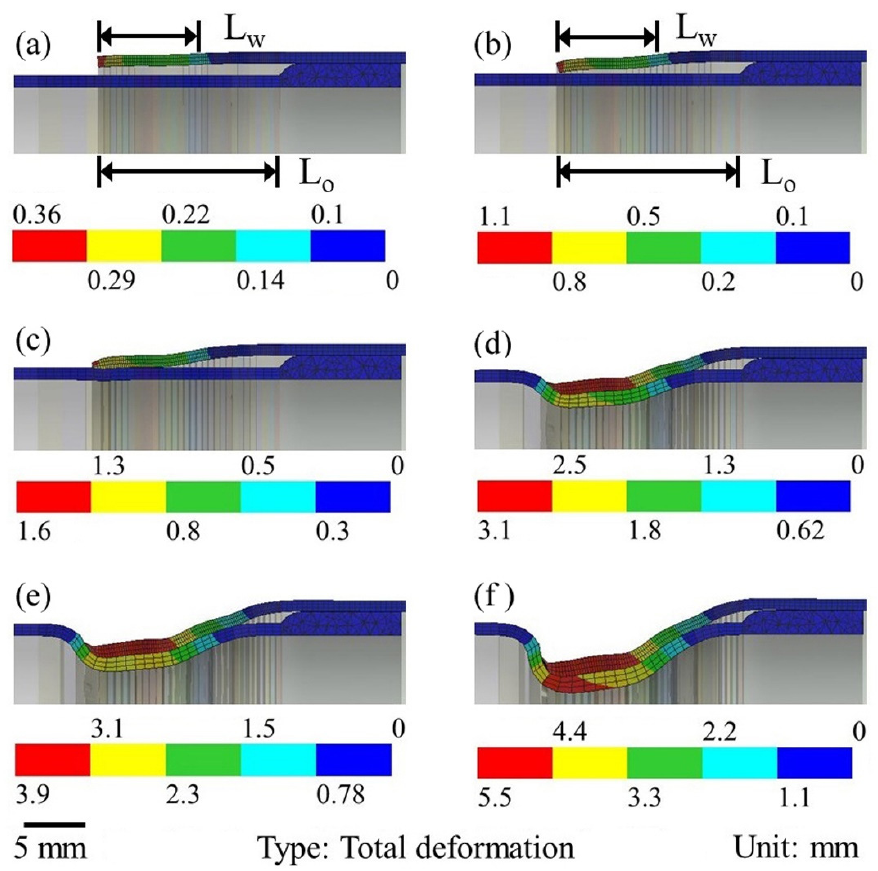
Figure 9. Computed results of the progressive impact and plastic deformation of the tube assembly at the time instants of ( a ) 7 µs, ( b ) 9 µs, ( c ) 11 µs, ( d ) 17 µs, ( e ) 21 µs and ( f ) 26 µs for a discharge energy of 14 kJ and with no internal support inside the target tube. (Initial conditions: wall thicknesses of flyer = 0.89 mm and of target = 1 mm; standoff distance between flyer and target = 1 mm; overlapping length between field shaper and flyer, L w = 8 mm and free length of the flyer tube, L o = 15